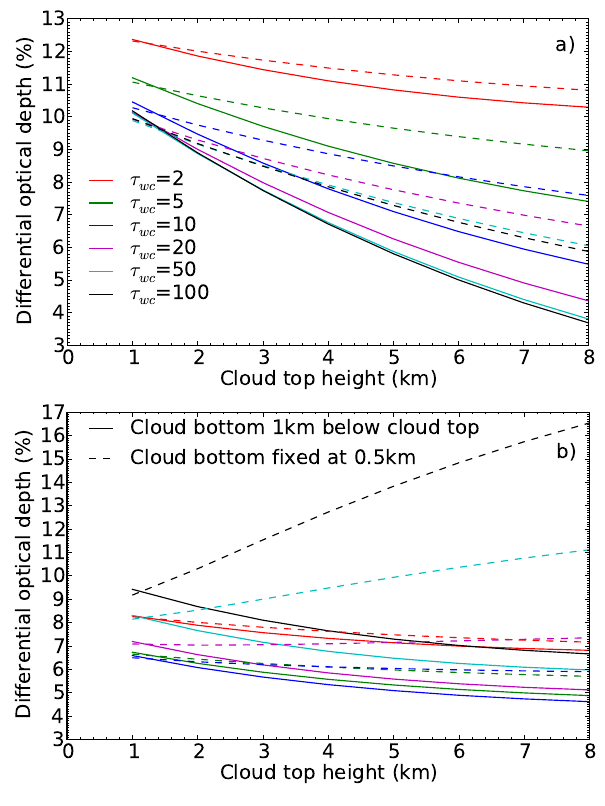
Fig. 3. The differential optical depth calculated (a) from top of the atmosphere nadir radiances, and (b) bottom of the atmosphere zenith radiances for a wavelength of 393.37nm. The solar zenith angle is 52 . 9 ◦ and the surface albedo is 0.05. For the solid lines the cloud is 1km thick in the vertical. For the dashed lines the cloud bottom is at 0.5km and the cloud vertical extent increases as the cloud top height increases.